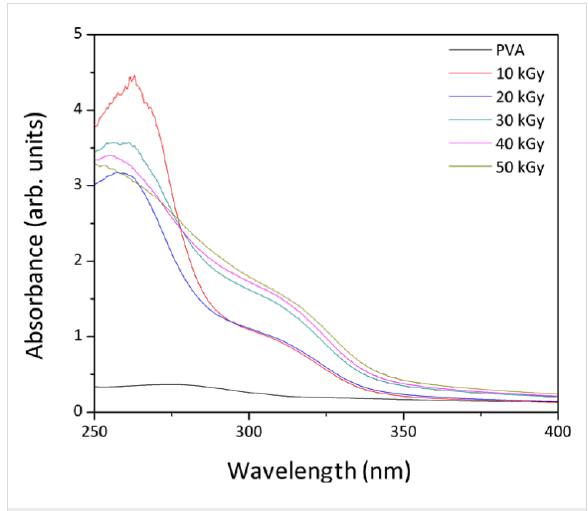
Figure 5: Optical spectra of ZnS–PVA nanofluids synthesized at various